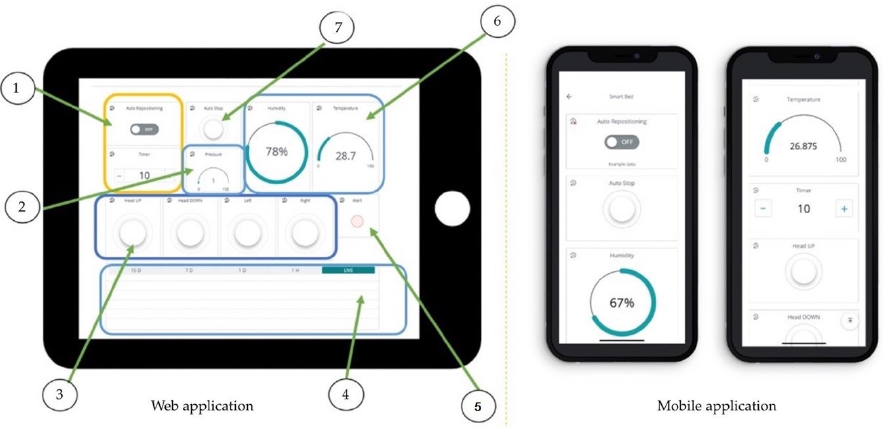
Figure 9. Web and mobile application.